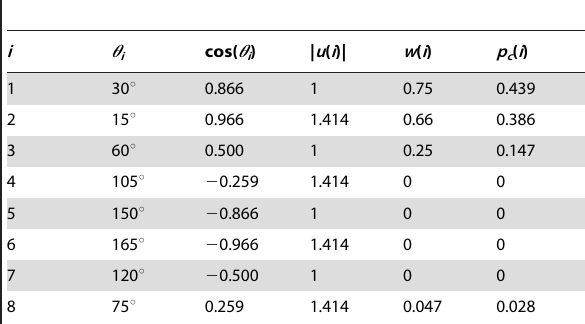
Table 2. Calculation of chemotactic jump probabilities p c for the 2D-lattice example of Fig.